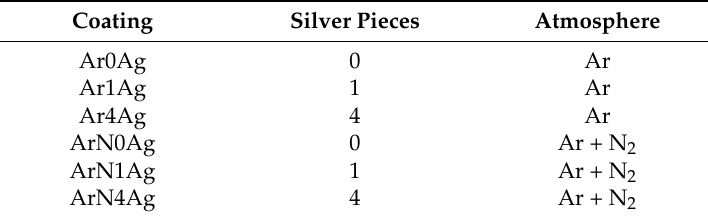
Stainless steel coatings deposited with and without Ag pieces and in inert and reactive